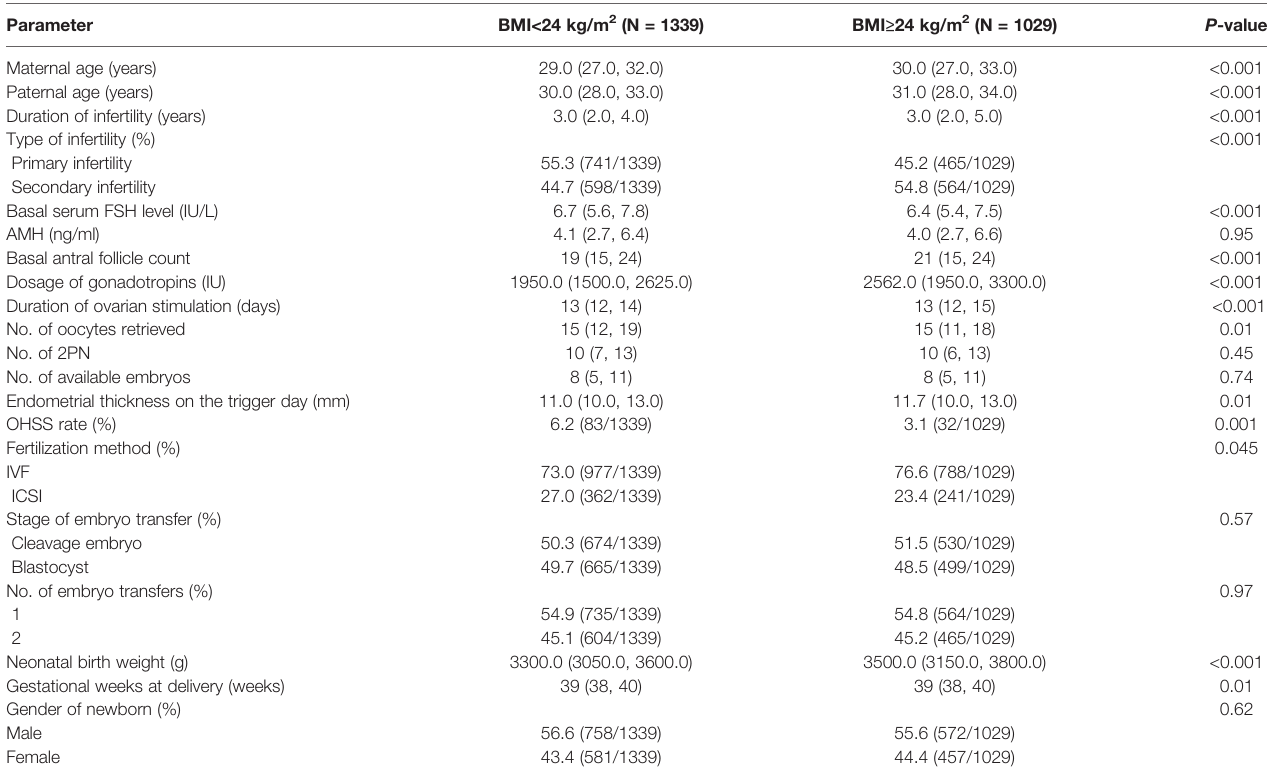
TABLE 1 | Baseline and cycle characteristics among patients with PCOS.